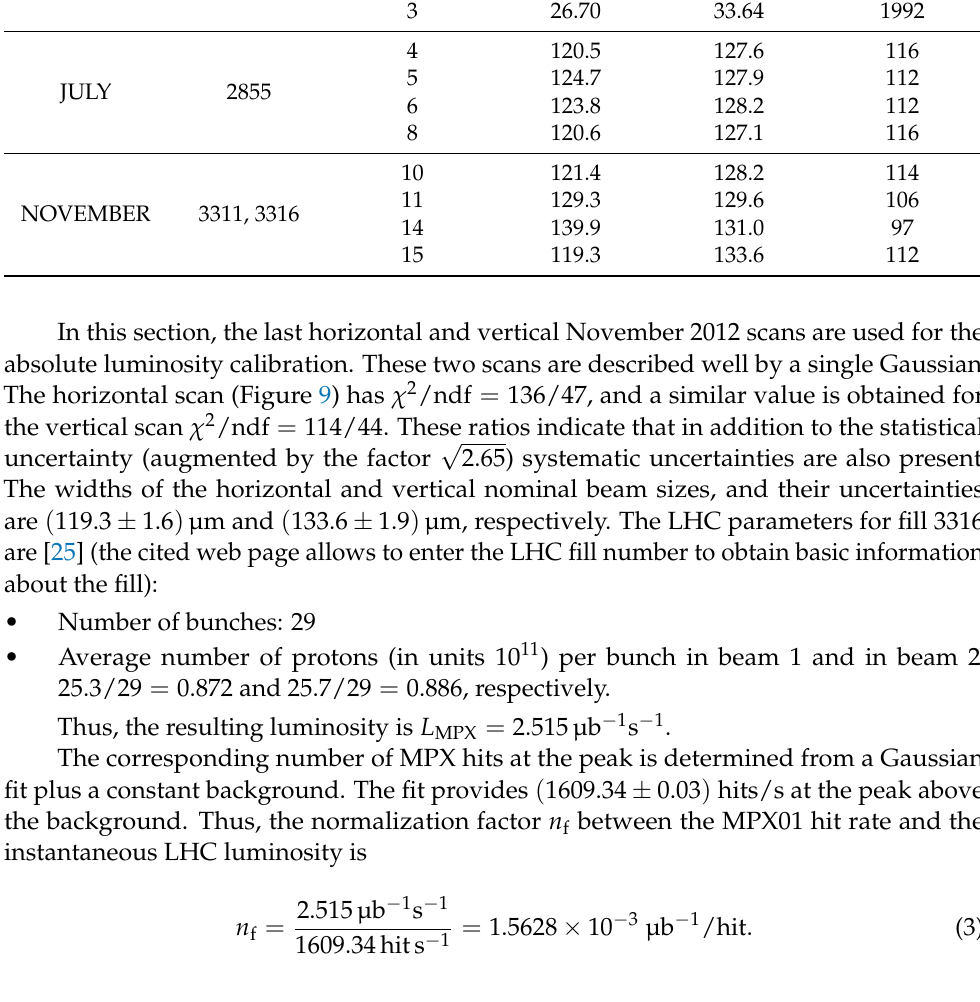
Fill Number Scan Σ x (µm) Σ y (µm) L